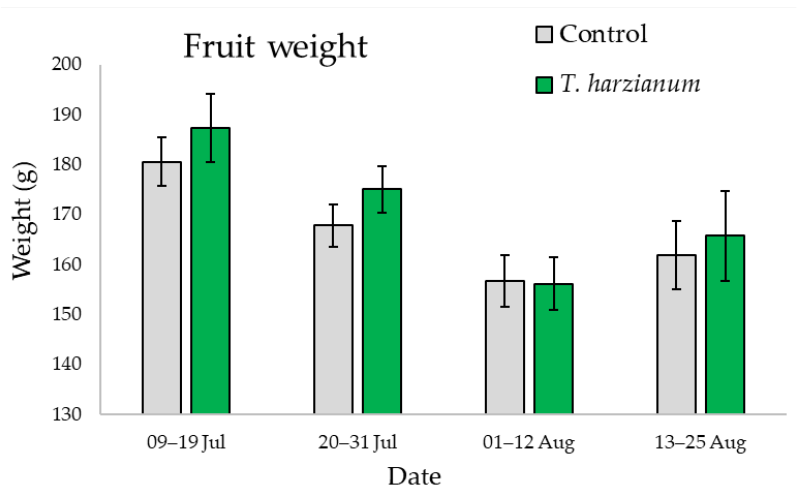
Figure 10. Mean values ( ± standard errors) of fruit weight from zucchini plants inoculated with T. harzianum T22 and control during the four sampling periods.